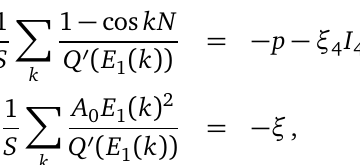
Figure 6: Comparison of energies for the various solutions, 0-gap, 2-gap, or 3-gap. We see that the 2-gap Ansatz is always at lower energy, whatever ξ ξ = 1. The values of ξ between the two dashed lines correspond to the physical 4 region of stability of the 3-gap state for ξ = 1 (see Fig.